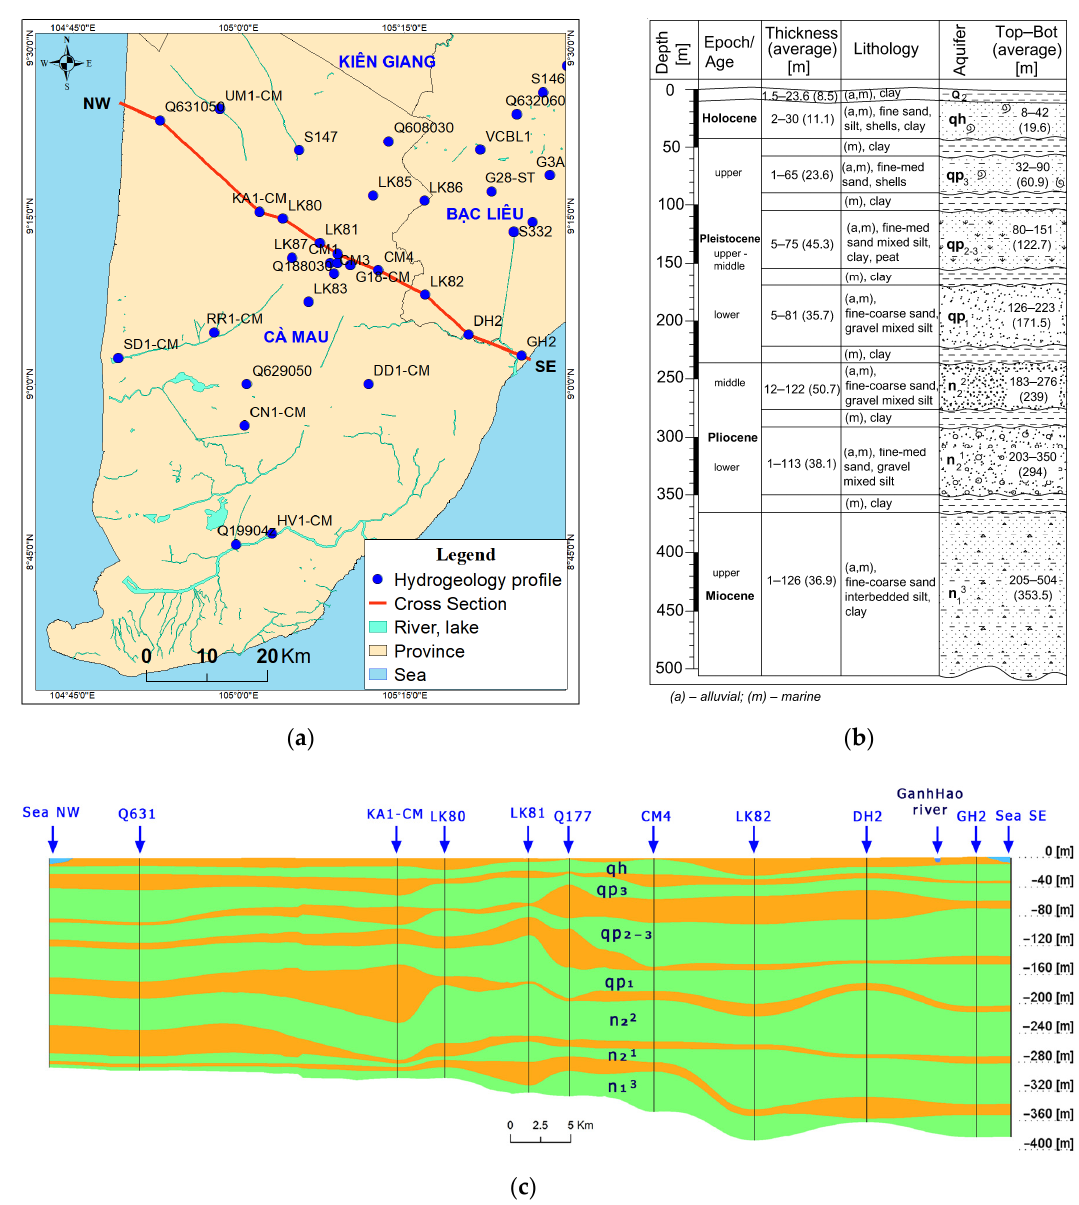
Figure 2. Position of cross-section NW–SE ( a ). Schematic representation of sedimentary aquifer succession in Ca Mau province ( b ). Cross-section of Ca Mau peninsula following the path NW–SE ( c ). (Sources of data: hydrogeological profiles collected by NAWAPI [21].)